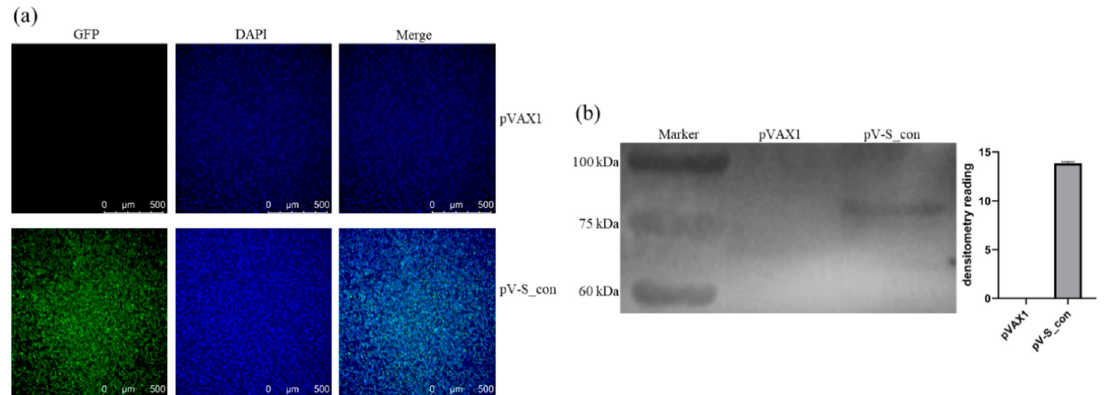
Figure 3. Expression of the S_con protein in vitro. ( a ) Expression of the S_con protein in HD11 cells analyzed by IFA. ( b ) Expression of the S_con protein in HD11 cells analyzed by Western blot.